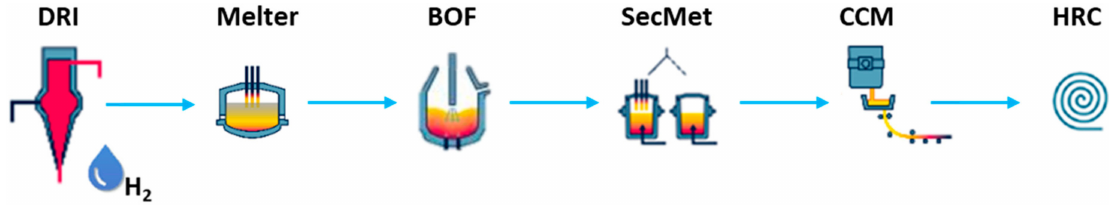
Figure 18. Possible LD concept for future steelmaking. Process Route combining DR-Plant, electric melting, and LD